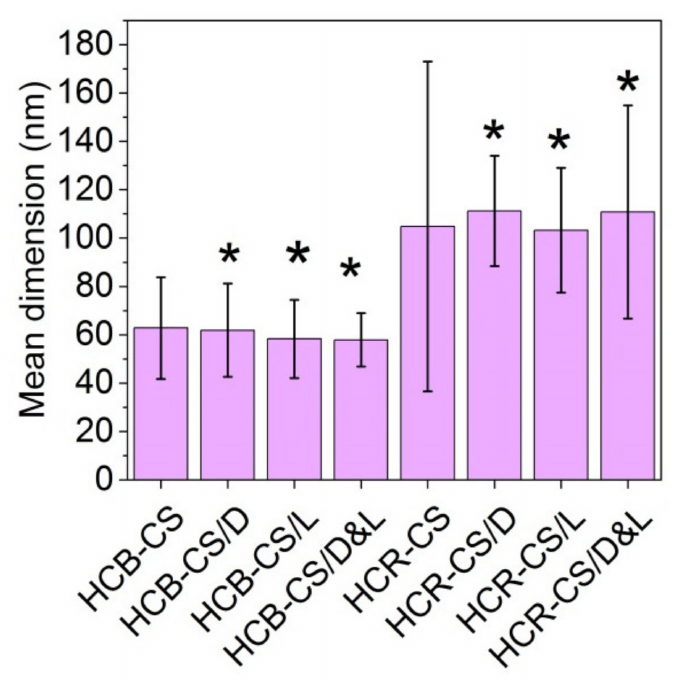
Figure 4. Average size nanofibers samples. Significant differences between the means of dimensions and the control (HCB-CS and HCR-CS) for * p < 0.05.